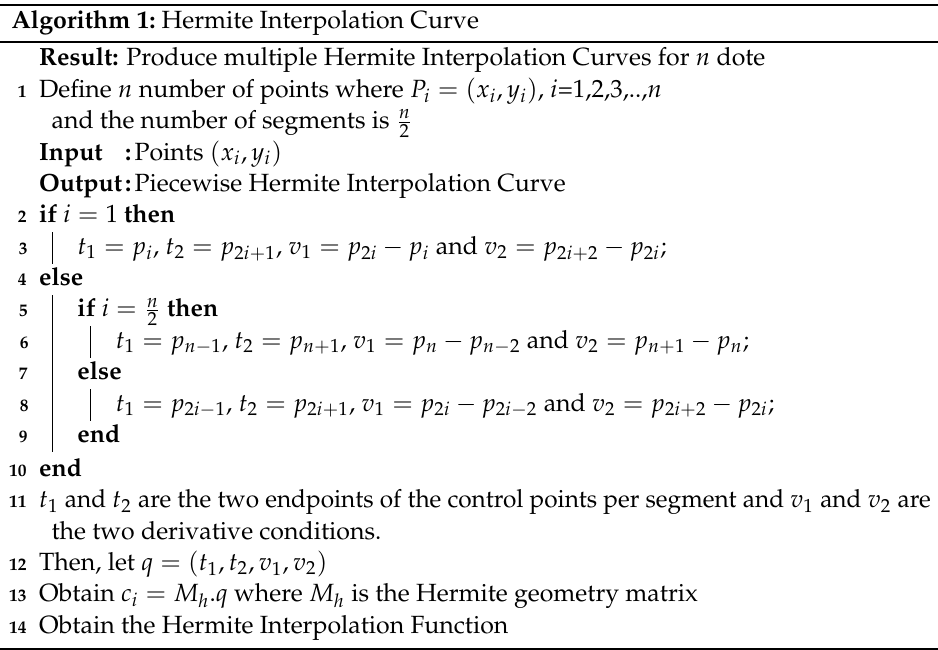
Algorithm 1: Hermite Interpolation